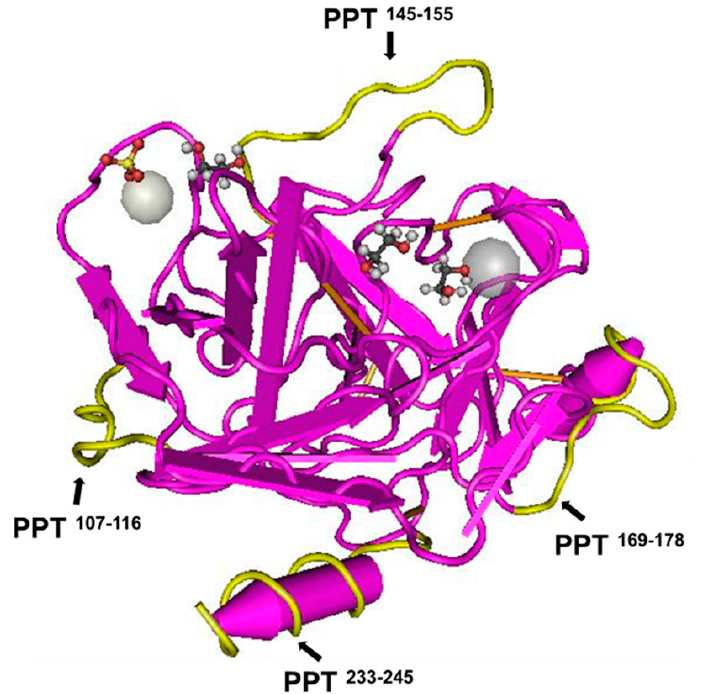
Figure 2. The structure of porcine pancreatic trypsin (cylinder: α -helix; arrow: β -sheet). The selected sequences are in yellow. These segments consist of the series: i.e., PPT 107–116 , PPT 145–155 , PPT 169–178 , and PPT 233–245 . The crystal structure of PPT was reproduced from http://www.ncbi.nlm.nih.gov/ and PDB ID: 1S81 [33].